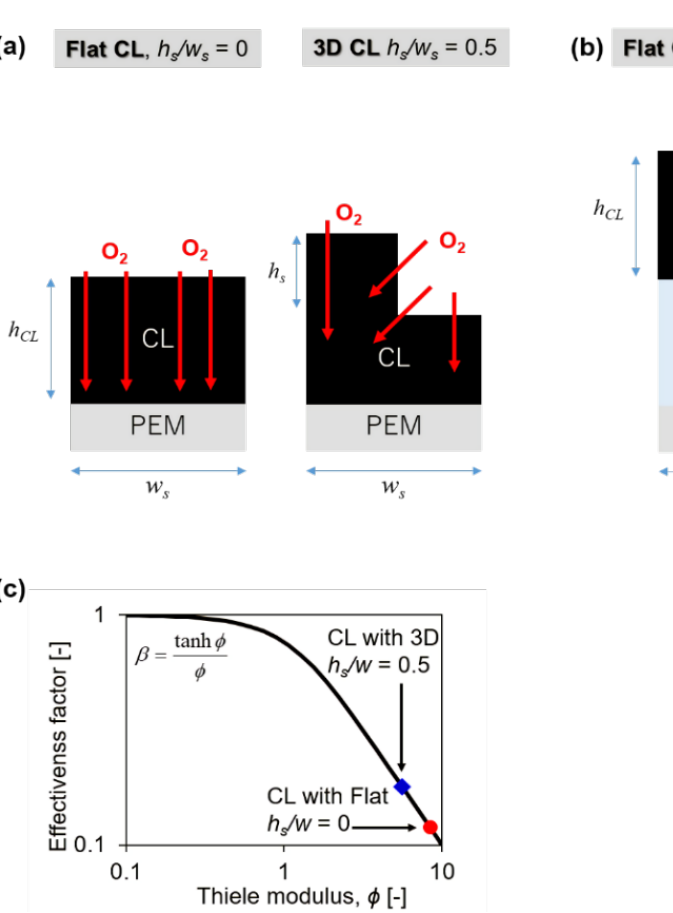
Figure 2. Calculation of ( a ) the diffusion length of oxygen, ( b ) the diffusion length of proton and ( c ) the relationship between the effectiveness factor and the Thiele modulus of the CCLs with flat and 3D structures. Calculation of the conduction length of flat- or 3D-patterned IL structures.